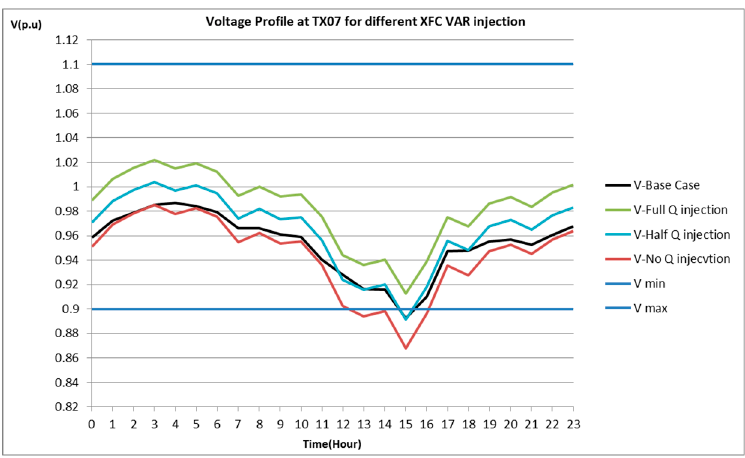
Figure 15. Voltage profile on tx-16 in different scenarios.